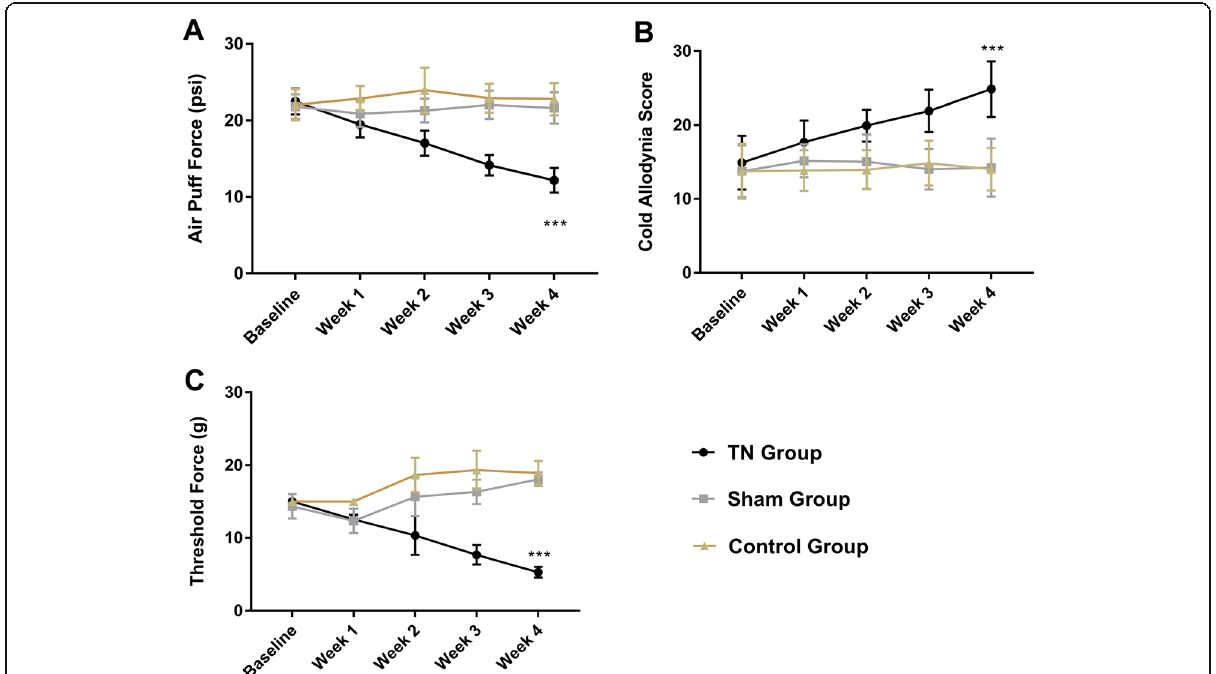
Fig. 3 Behavioral test results for the TN, sham, and control groups. a Air-puff test results for the ipsilateral trigeminal facial area. b Cold hyperalgesia results for the ipsilateral facial area following treatment with acetone drops. c Mechanical allodynia (von Frey test) results for the ipsilateral facial side. ***, p < 0.001, significant difference determined via an analysis of variance